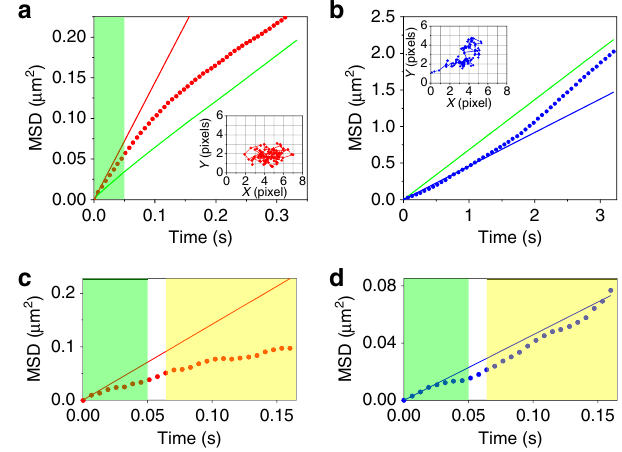
Figure 8 | MSD analyses of the sub-trajectories. ( a ) Averaged MSD- D t profile of the sub-trajectories captured in the –ALV zone of the first mode-set. The green line shows the overall MSD- D t profile obtained from the original experimental replicates (Fig. 2c). The red line shows the theoretical MSD- D t profile of the averaged MSD- D t profile. ( b ) Averaged MSD-10 D t profile of the sub-trajectories captured in the –ALV zone of the second mode-set. The green line shows the overall MSD-10 D t profile obtained from the original experimental replicates. The blue line shows the theoretical MSD-10 D t profile of the averaged MSD-10 D t profile. Insets in a , b show examples of single-molecule sub-trajectories obtained from the –ALV zone of the first mode-set and the –ALV zone of the second mode-set, respectively. ( c ) MSD- D t profile of the sub-trajectory shown in the inset of a . The red line shows the theoretical MSD- D t profile. ( d ) MSD- D t profile of the sub-trajectory shown in the inset of b . The blue line shows the theoretical MSD- D t profile. The green shaded area in a , c , d highlights part of the MSD profiles whose time scale shows sub-diffusive behaviour. The yellow shaded area in c , d highlight part of the MSD profile whose time scale Figure 7 | Step sizes in the sub-trajectories. ( a ) Frequency histograms of shows linear diffusive behaviour. This part of the profile shows either the step-size distributions of the sub-trajectories obtained from an confined-like ( c ) or directed-like motion ( d ) compared with the theoretical experimental replicate of ColE 1 DNA whose temporal positions are profile. extracted from ALV (red and blue histograms for the first and second mode-set in –ALV zone, and green and shaded-green histograms for the first and second mode-set in þ ALV zone) by setting the thresholds at of the P 25 profile compared with those of the MSD profile (that is, ± 2.2 s in our analytical approach, the diffusive motion is mainly ALV . ( b ) The mean step sizes obtained from the experimental (red and blue circles for the first and second mode-set, respectively) and S r A r characterized by the relative diffusion modes—c-LO and d-HO simulated (green circles and green squares for the second and first sub-modes for the first and second mode-sets, respectively), the mode-set, respectively) sub-trajectories of ColE 1 DNA at different threshold results also demonstrate that lattice occupancy analysis can levels (0.1 s ALV – 2.2 s ALV ). The mean step-sizes were determined by fitting capture non-random diffusion modes. The step sizes obtained the step-size distributions to equation (5). The dashed line shows the ALV from the peaks detected in the þ ALV zones, which mainly threshold at which 10% of the data are collected. ( c ) The mean step sizes reflect the absolute diffusion modes (that is, directed- or obtained from the experimental (red and blue circles for the first and confined-like motion), do not show any deviations from the second mode-set, respectively) and S r A r simulated (green circles and green average step size (Fig. 7a–c), demonstrating that these sub-modes squares for the second and first mode-set, respectively) sub-trajectories of captured by MSD analysis do not exhibit non-random behaviour. the nanospheres at different threshold levels (0.1 s ALV (cid:2) 2.0 s ALV ). Error bars We further characterized the LO and HO modes detected in in b , c correspond to the s.d.‘s of the step sizes at each threshold level the above analyses by reconstructing corresponding MSD- D t obtained from 100 replicates. plots (Supplementary Data 6). The MSD- D t plots reconstructed from the region of the diffusion trajectories that display the LO the negative peaks in the ALV plots are responsible for the larger sub-mode clearly showed confined-like motion (c-LO sub-mode) and smaller step sizes in the first and the second mode-set, (Fig. 8a,c). On the other hand, the MSD- D t plots obtained from respectively (Fig. 7b). We did not observe this threshold the HO sub-mode region exhibited directed-like motion (d-HO dependency in the negative peaks detected in the ALV plots sub-mode) (Fig. 8b,d). The MSD- D t plots of the simulated S r A r obtained from the nanospheres (Fig. 7c) and the simulated S r A r replicates that were reconstructed from the regions with negative replicates (Fig. 7b) (that is, those peaks are assigned to the ALV peaks exhibited normal diffusion (Supplementary Fig. 7a), apparent non-random diffusion caused by the statistical confirming the existence of unexpected c-LO and d-HO variations intrinsic to Brownian motion). These results further sub-modes that are responsible for the non-random motion of demonstrate that the sub-trajectories corresponding to the ALV the DNA in homogeneous isotropic environments. On the other peaks in the negative zones display non-random diffusion modes. hand, the MSD- D t plots obtained from the positive ALV zones of Since the negative ALV peaks correspond to the larger amplitudes the DNA trajectories were indistinguishable from the simulated NATURE COMMUNICATIONS|8:15675|DOI: